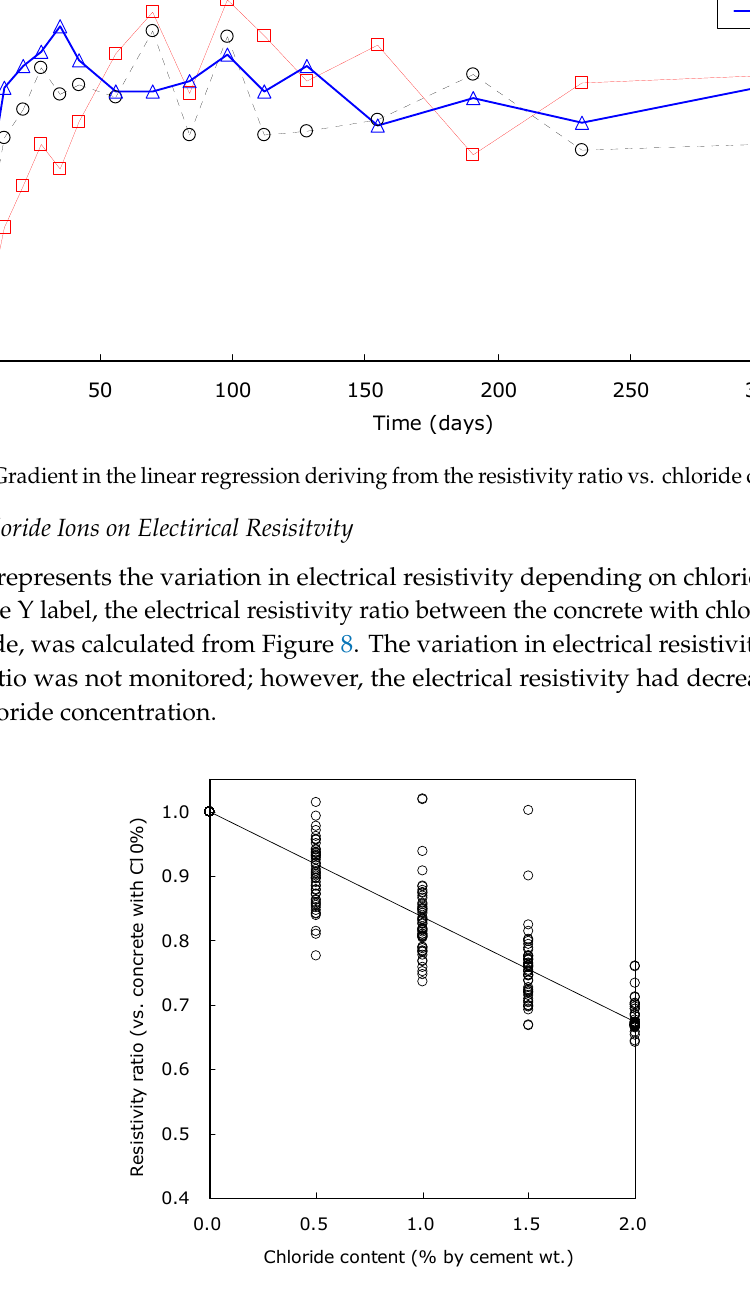
Figure 11. Chloride concentration vs. resistivity of the concrete.